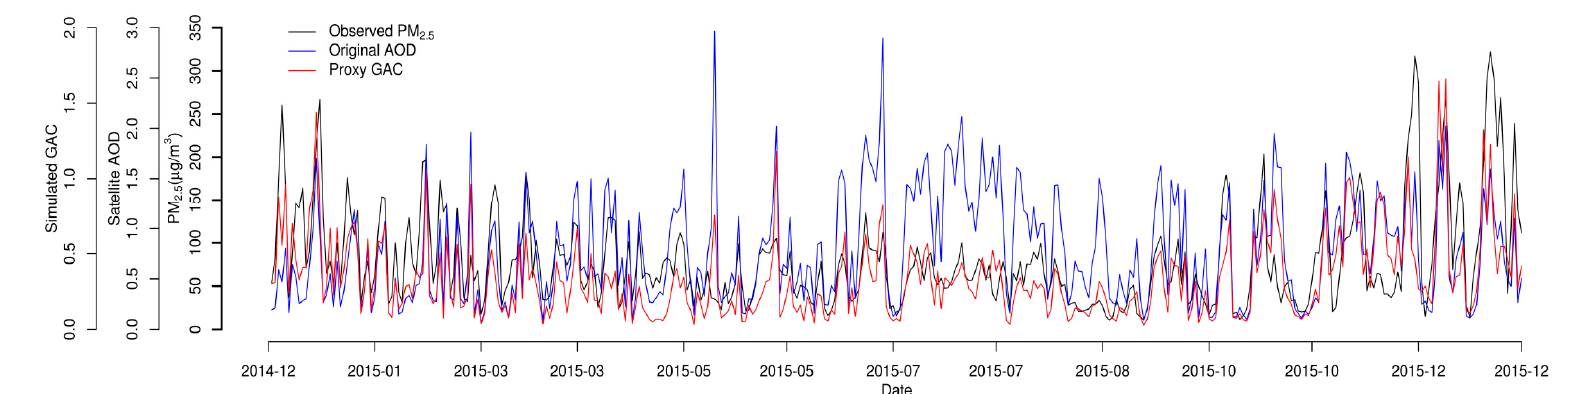
Remote Sens. 2019 , 11 , x FOR PEER REVIEW Figure 7. Time-series plots for PM2.5, satellite AOD, and simulated GAC by automatic differentiation (AD).